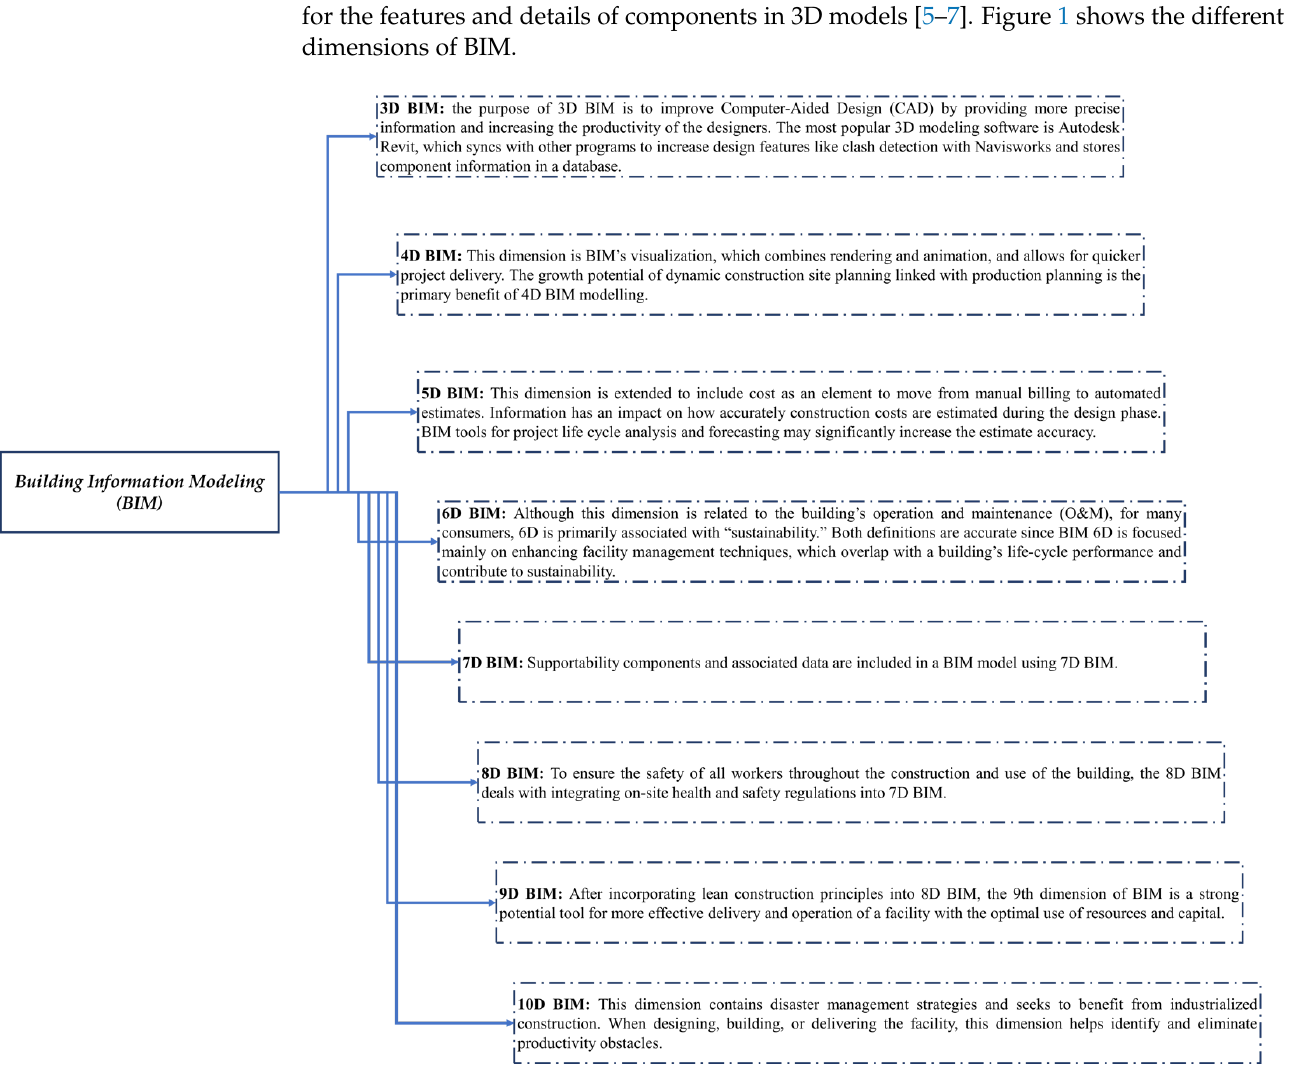
Figure 1. Different dimensions of BIM [8 – 21].